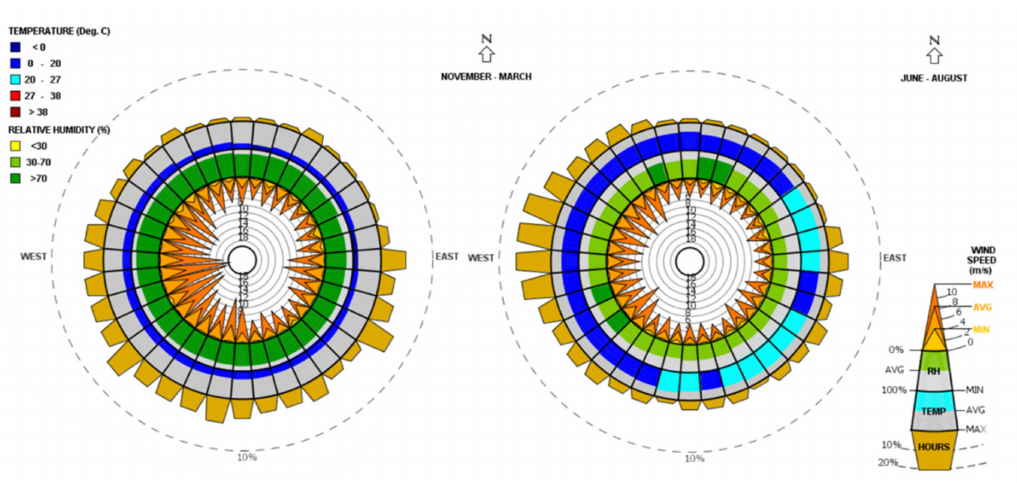
Figure 7. Prevailing winds in winter and summer in Berlin,